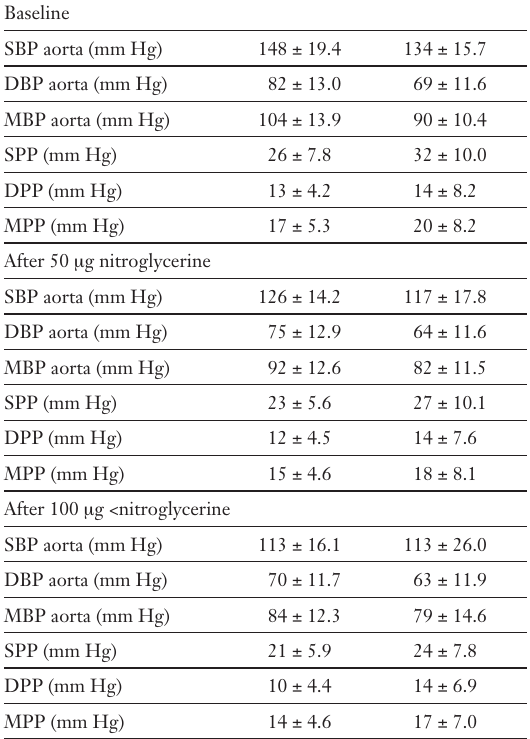
Blood pressure at baseline and following nitroglycerin infusion. Blood pressure values measured in the aorta and the pulmonary artery during the haemodynamic study at baseline and following nitroglycerin infusion. Data are expressed as mean ±